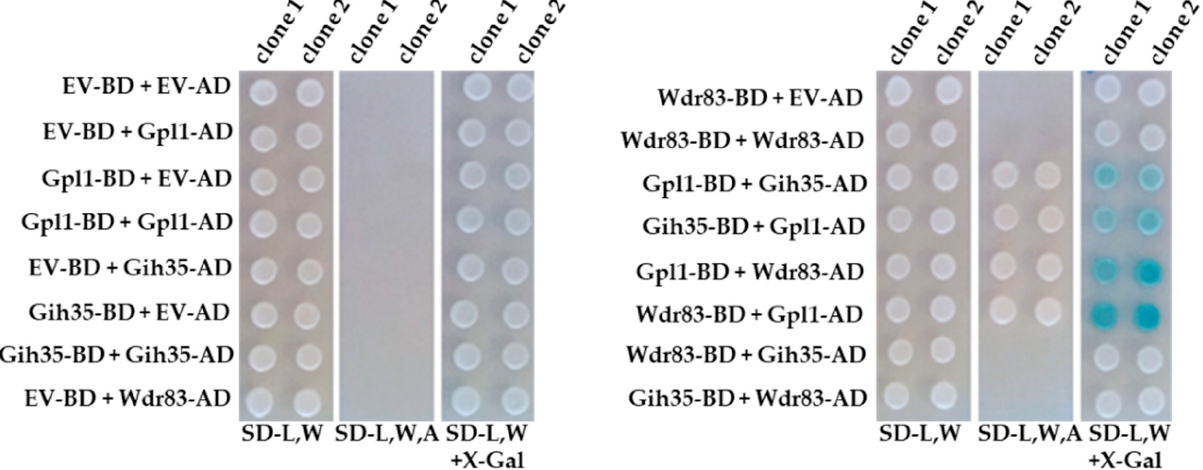
Figure 2. Physical protein–protein interactions between Gpl1, Gih35 and Wdr83 proteins analyzed by the Y2H assay. EV-BD or EV-AD and protein-BD or protein-AD indicate empty Y2H vector bearing binding or activation domains and Y2H vectors expressing protein of interests fused with binding or activation domains, respectively. SD-L,W—synthetic dropout media without leucine and tryptophan; SD-L,W,A—synthetic dropout media without leucine, tryptophan and adenine; SD-L,W—synthetic dropout media without leucine and tryptophan and supplemented with